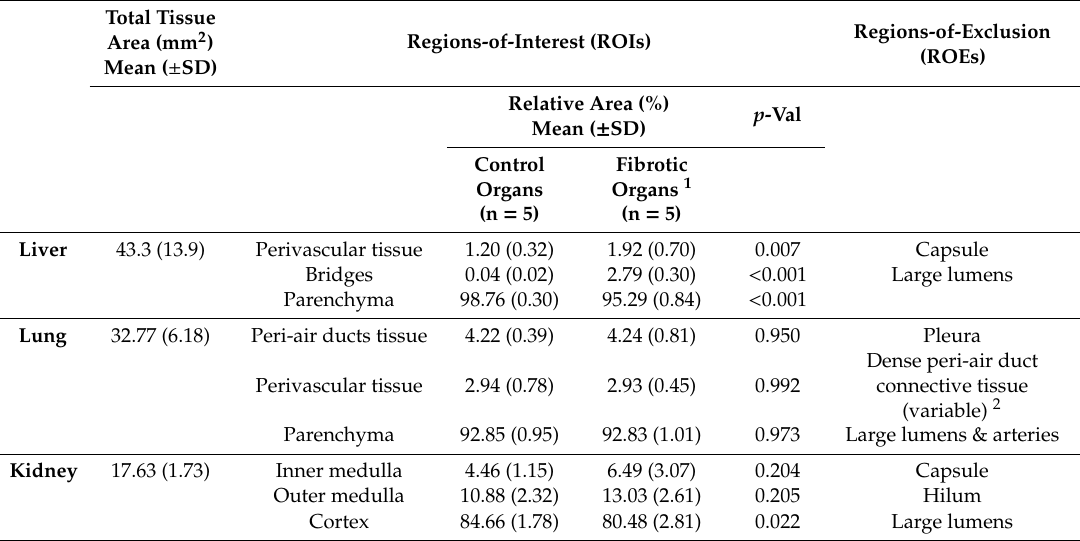
Table 1. Characteristics of regions-of-interest (ROIs) and regions-of-exclusion (ROEs).